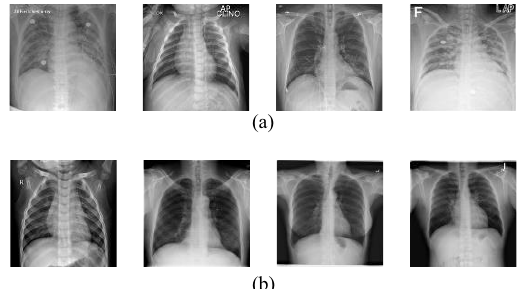
Cumulative histogram before equalization